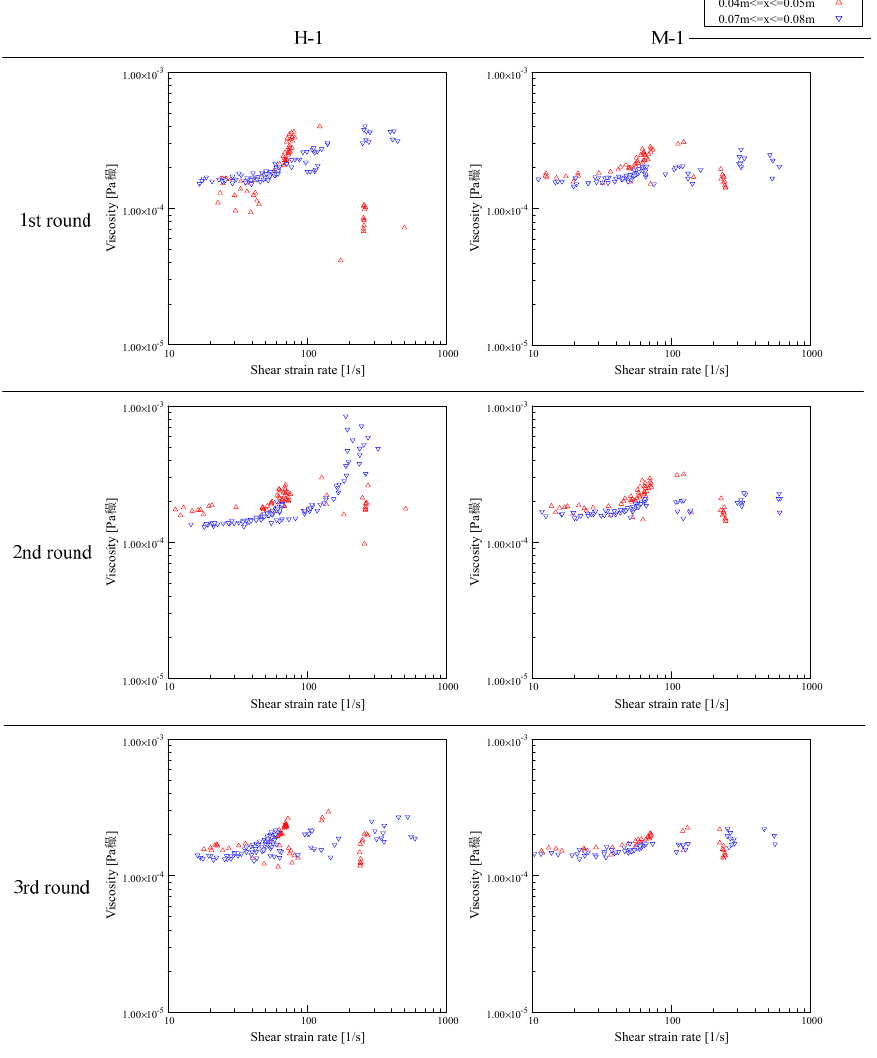
Figure 24. Relationship between the shear strain rate and the viscosity coefficient from the simulation results. The red mark shows 0.04 to 0.05 m as the deceleration range, and the blue mark shows 0.07 m to 0.08 m as the acceleration region.